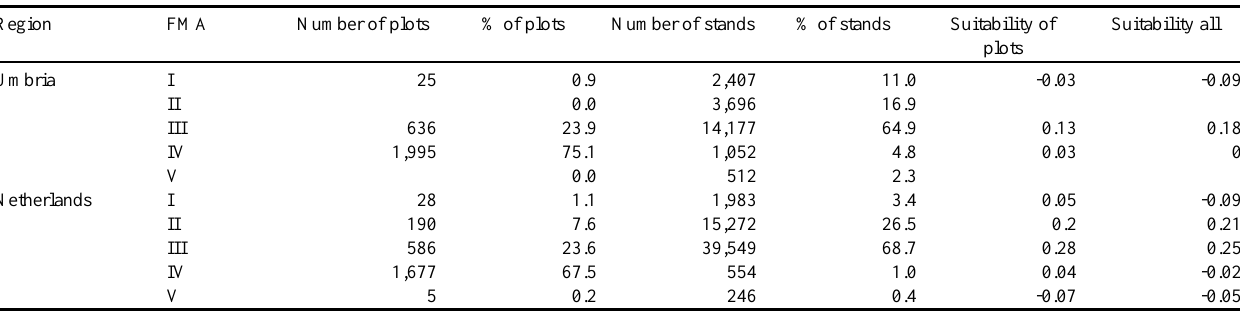
Table 7 . Distribution and suitability index of observed forest management approaches (FMAs) in Umbria and the Netherlands. Distribution is given for plots (observations) and stands (predictions), both in absolute numbers and in percentages. Calculated suitability indices for the recorded FMA at the plot data locations (Suitability of plots) are compared to average suitability of this FMA within the region (Suitability all). (FMA I: nature reserve; II: close-to-nature; III: combined objective; IV: even-aged forestry; V: short rotation) Region FMA Number of